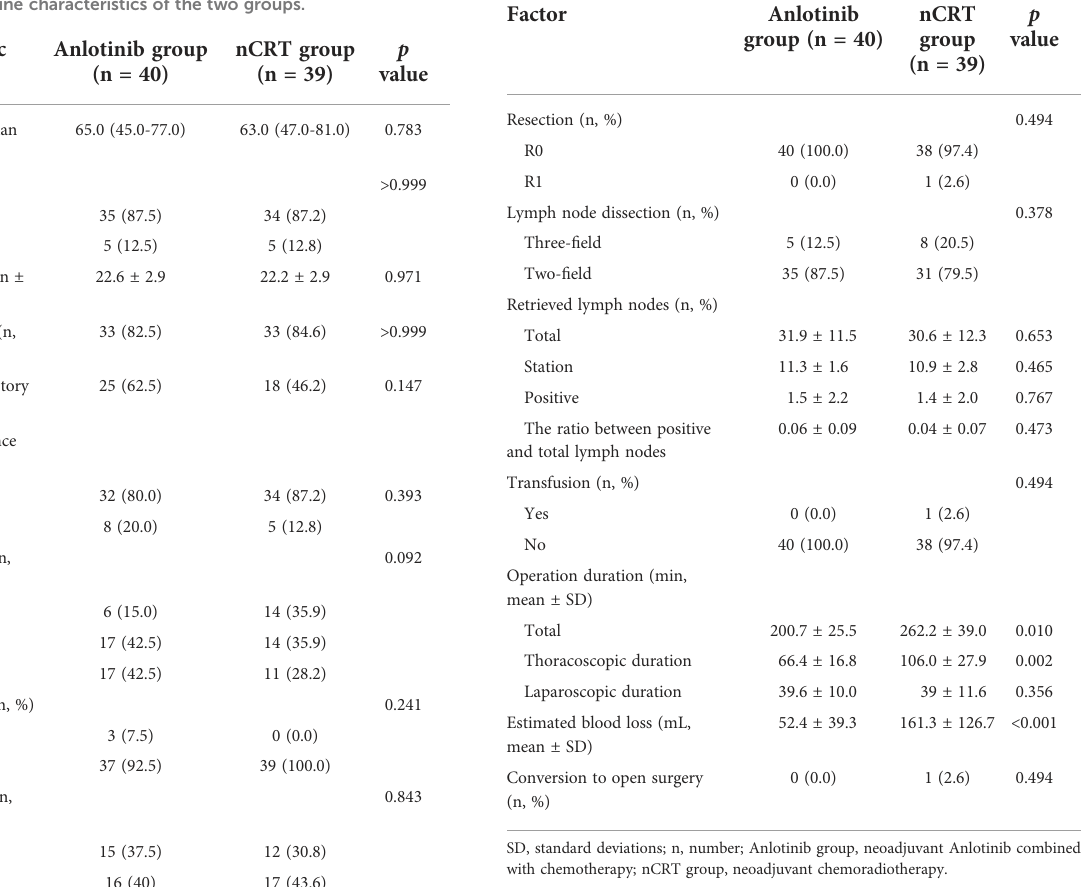
TABLE 1 Baseline characteristics of the two groups.